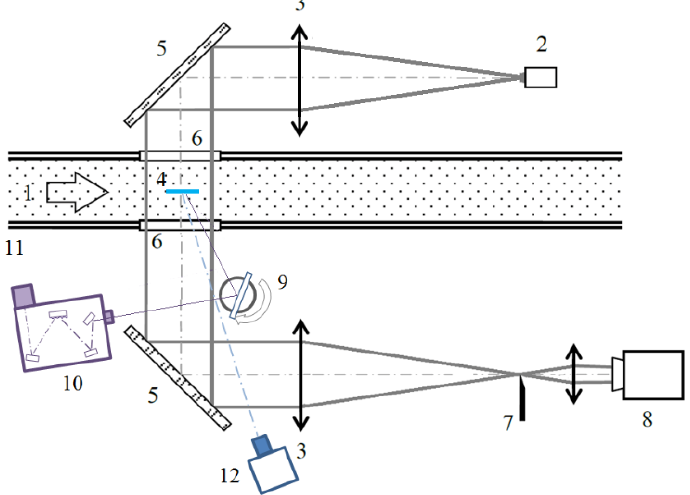
Figure 2. Scheme of optical measurements and visualization. 1 — supersonic flow; 2 — laser beam; 3 — lens, F = 1.5 m; 4 — electric discharge DC; 5 — mirror; 6 — transparent window; 7 — knife-edge; 8 — high-speed camera; 9 — rotating mirror for spectrograph; 10 — monochromator; 11 — spectrum